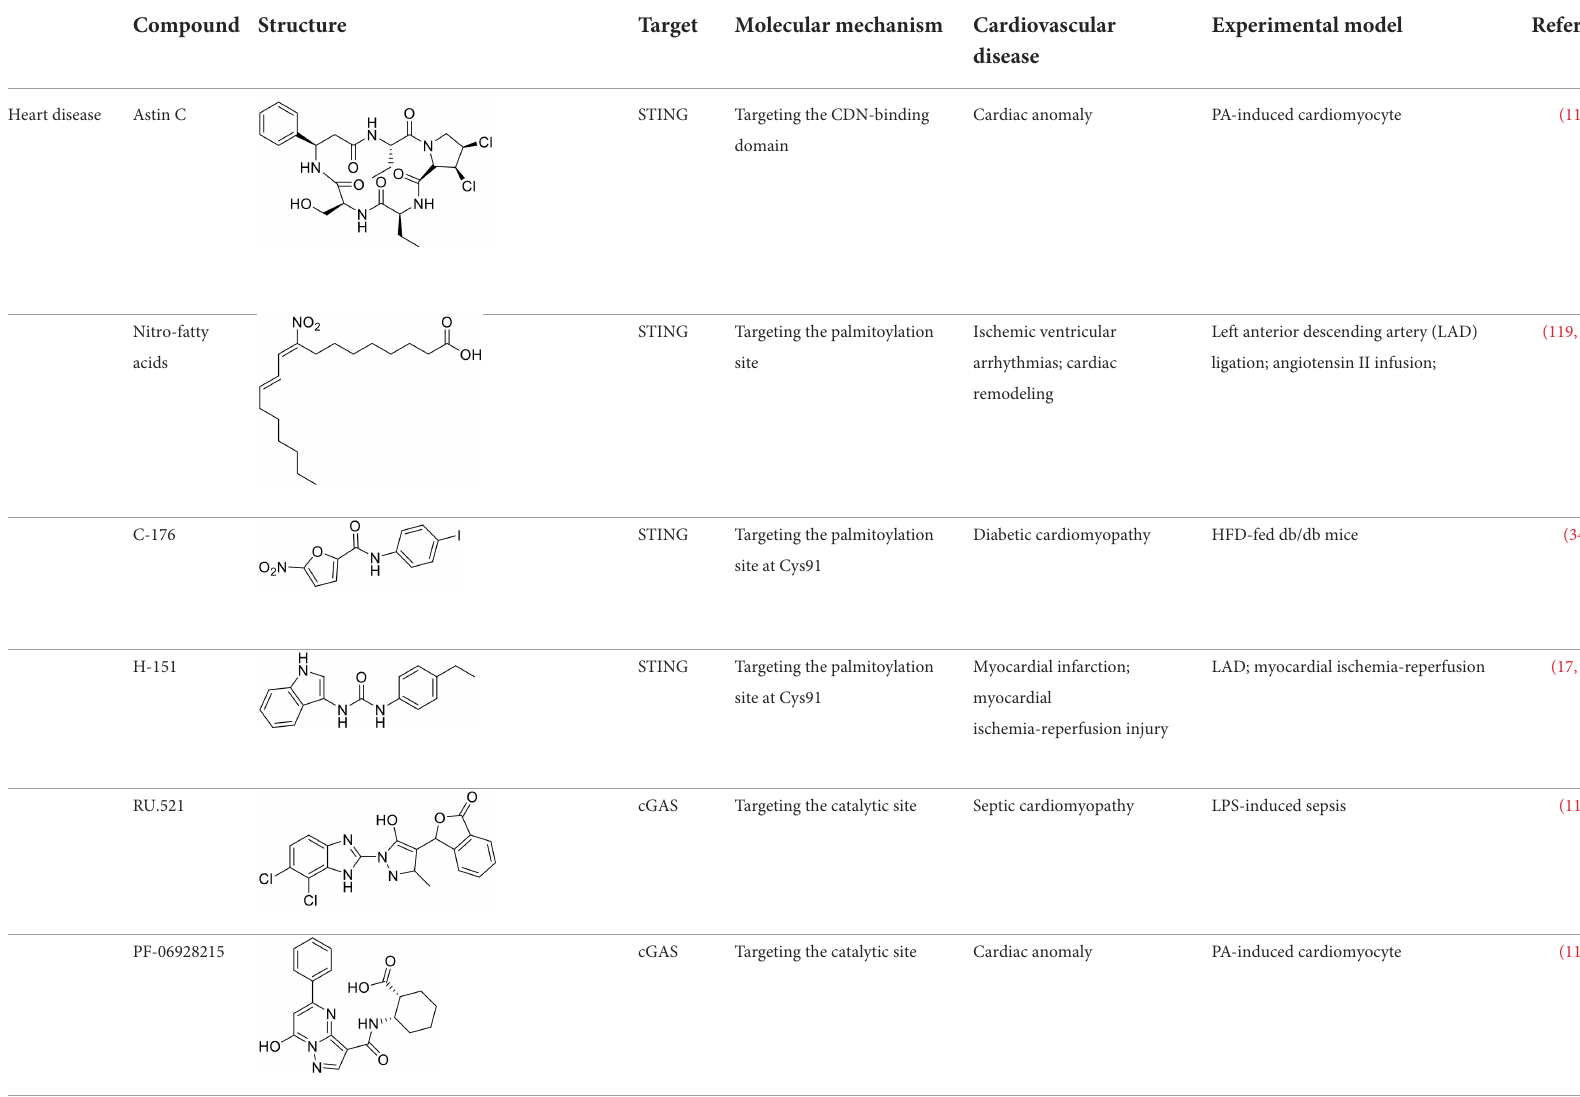
TABLE 2 STING or cGAS inhibitors proven to exert protective effects in experimental models of cardiovascular